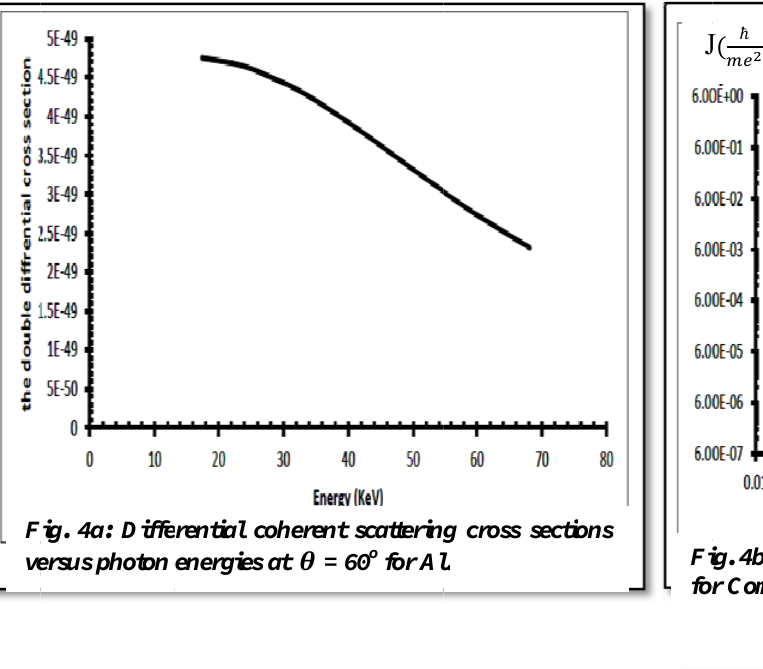
theoretical an the theoreti e.